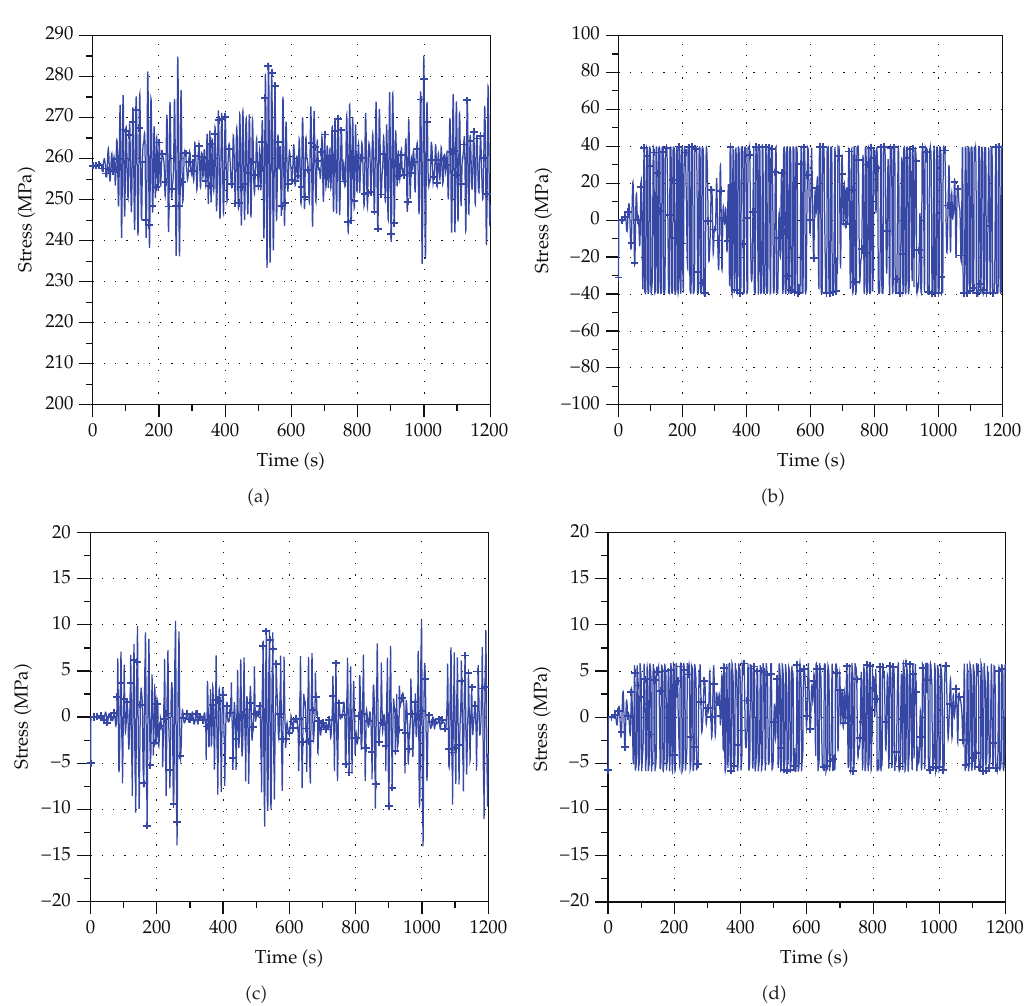
Figure 9: Time histories of stresses in wire 10 (cid:3) corner with the highest fatigue damage (cid:4) of the inner tensile armor: (cid:3) a (cid:4) axisymmetric stresses; (cid:3) b (cid:4) normal friction stresses; (cid:3) c (cid:4) normal bending stresses; (cid:3) d (cid:4) transverse bending